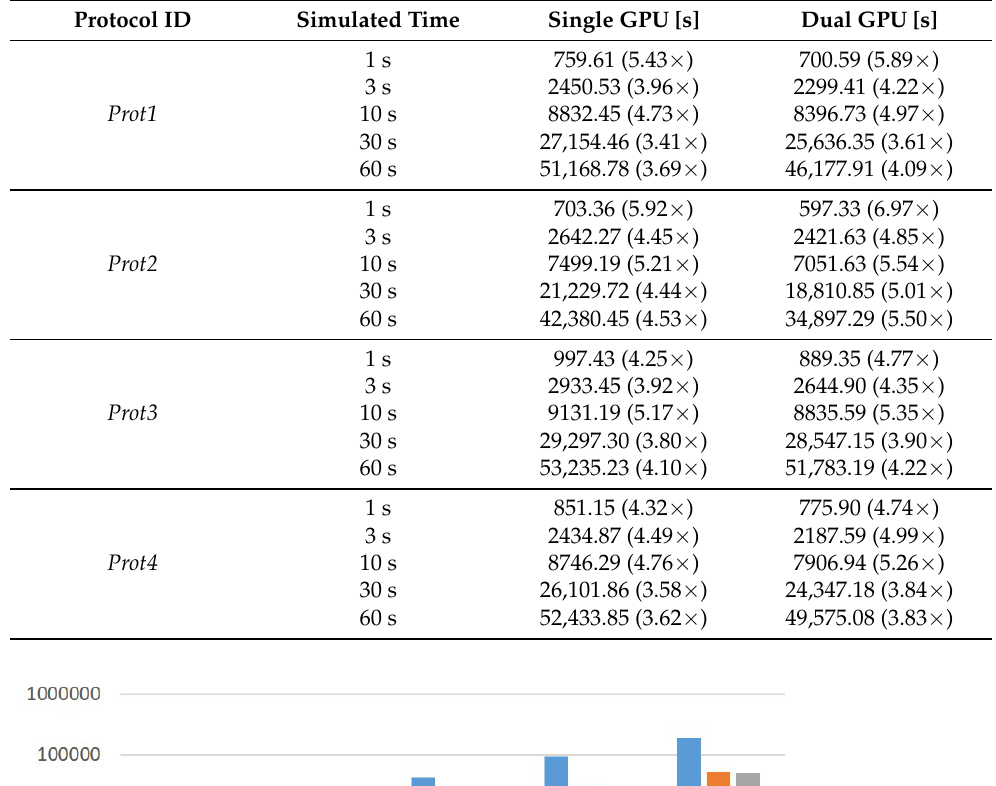
Table 8. Processing time for the network Network3 . The speed-up is indicated between brackets.